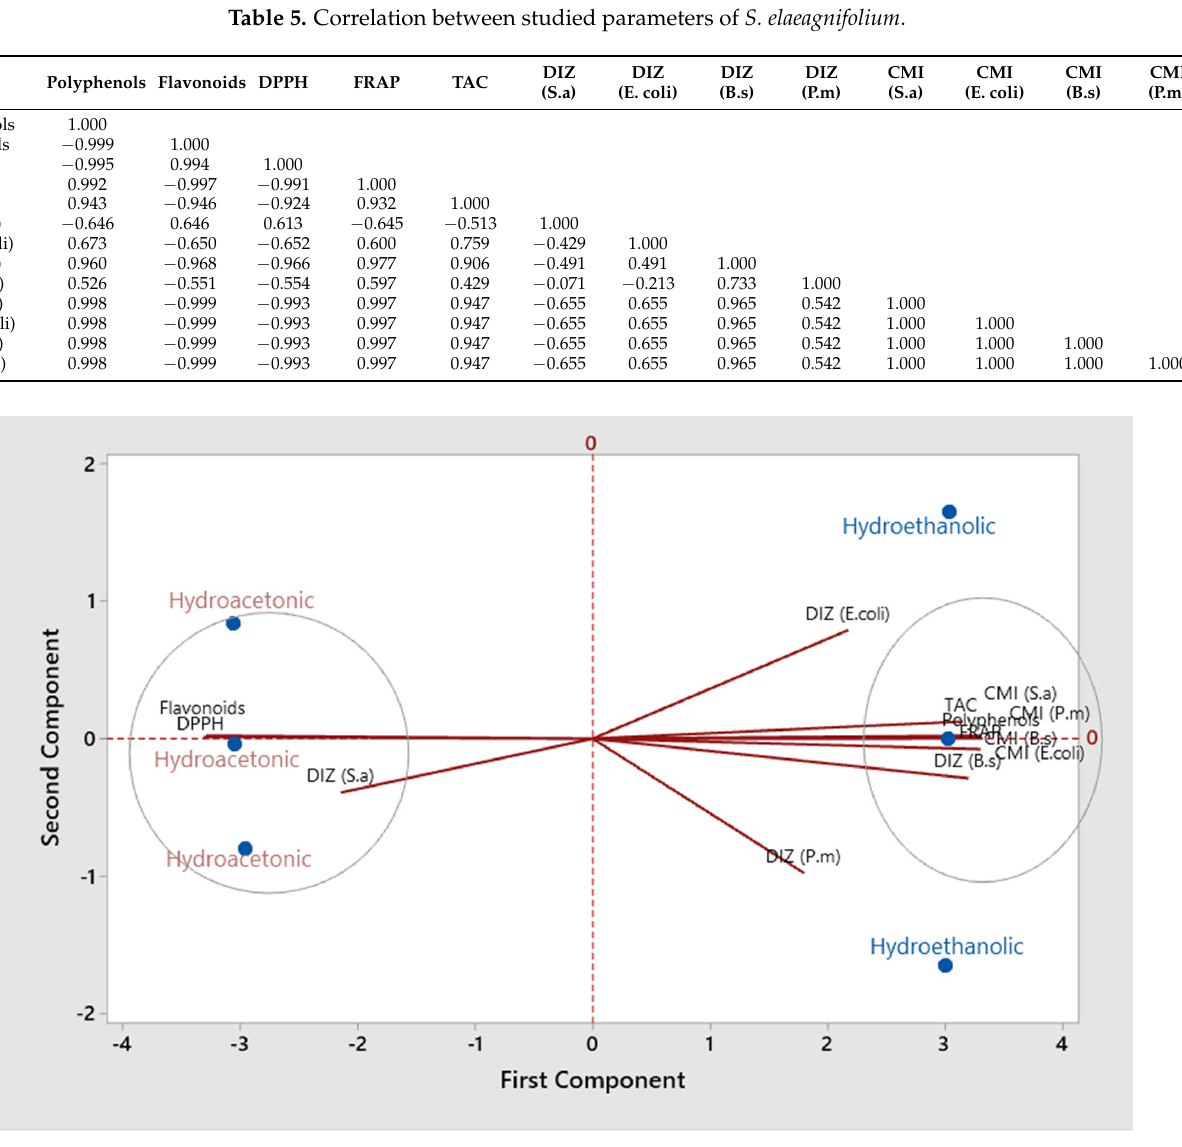
Figure 7. Factor analysis (PCA) of the examined extracts using the evaluated parameters